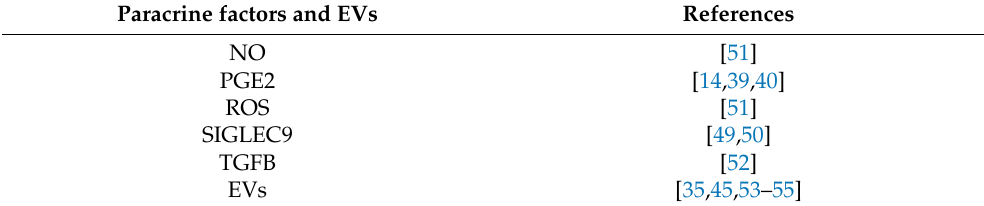
Table 1. Cont. Paracrine factors and